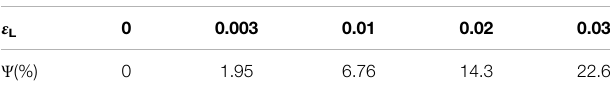
TABLE 4 | Apparent permeability deviation at different Langmuir